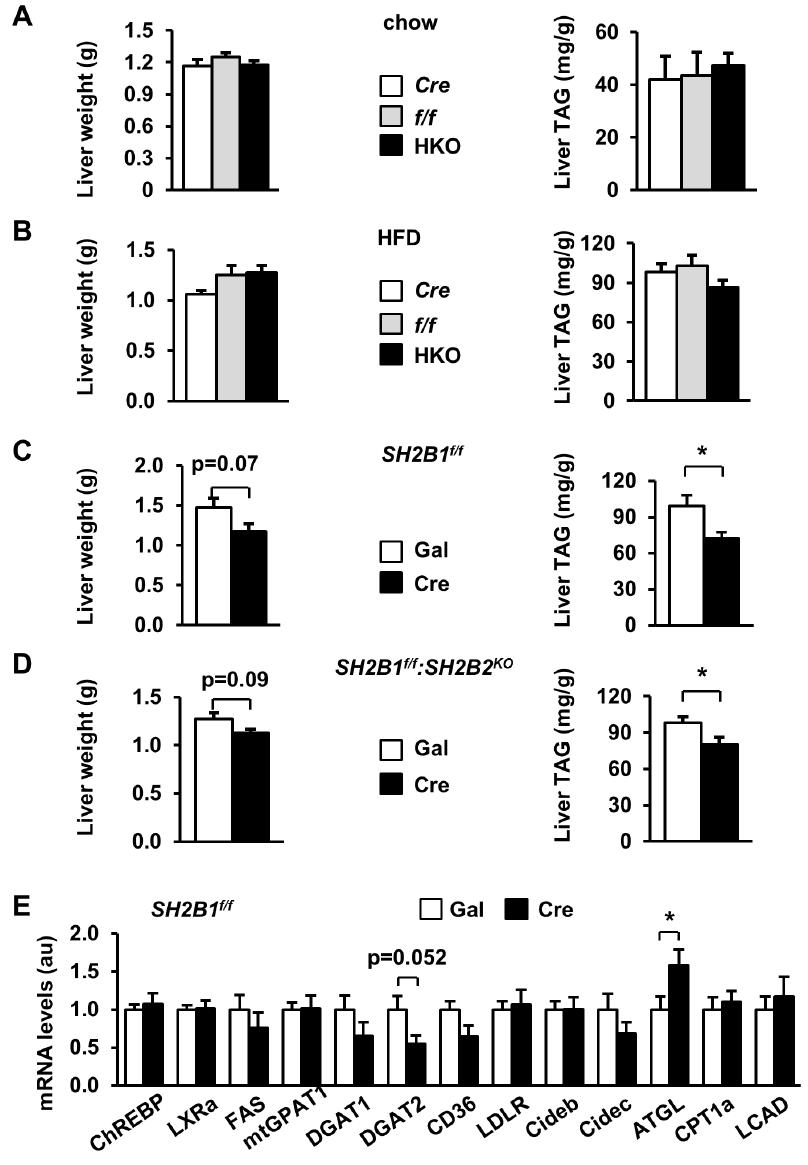
Figure 7. Hepatocyte-specific deletion of SH2B1 attenuates HFD-induced hepatic steatosis. (A) Liver weight and liver TAG levels (normalized to liver weight) of overnight-fasted male mice (21 weeks of age). f/f : n=10; Cre : n=7; HKO: n=10. (B) Male mice (7 weeks of age) were fed a HFD for 14 weeks. Liver weight and TAG levels of overnight-fasted mice. f/f : n=10; Cre : n=7; HKO: n=10. (C) SH2B1 f/f male mice (7 weeks of age) were fed a HFD for 5 weeks and infected with b -gal (n=7) or Cre adenoviruses (n=6) via tail vein injection. Liver weight and TAG levels were measured in fasted mice 29 days after adenoviral infection. (D) SH2B1 f/f :SH2B2 KO male mice (7 weeks of age) were fed a HFD for 5 weeks and infected with b -gal (n=6) or Cre adenoviruses (n=6). Liver weight and TAG levels were measured in fasted mice 29 days after adenoviral infection. (E) Total liver mRNA was prepared from the mice described in (C) and used to measure mRNA levels of the indicated genes by qPCR and normalized to b -actin expression. The values were further normalized to the b -gal group. Data are presented as means 6 SEM. P ,